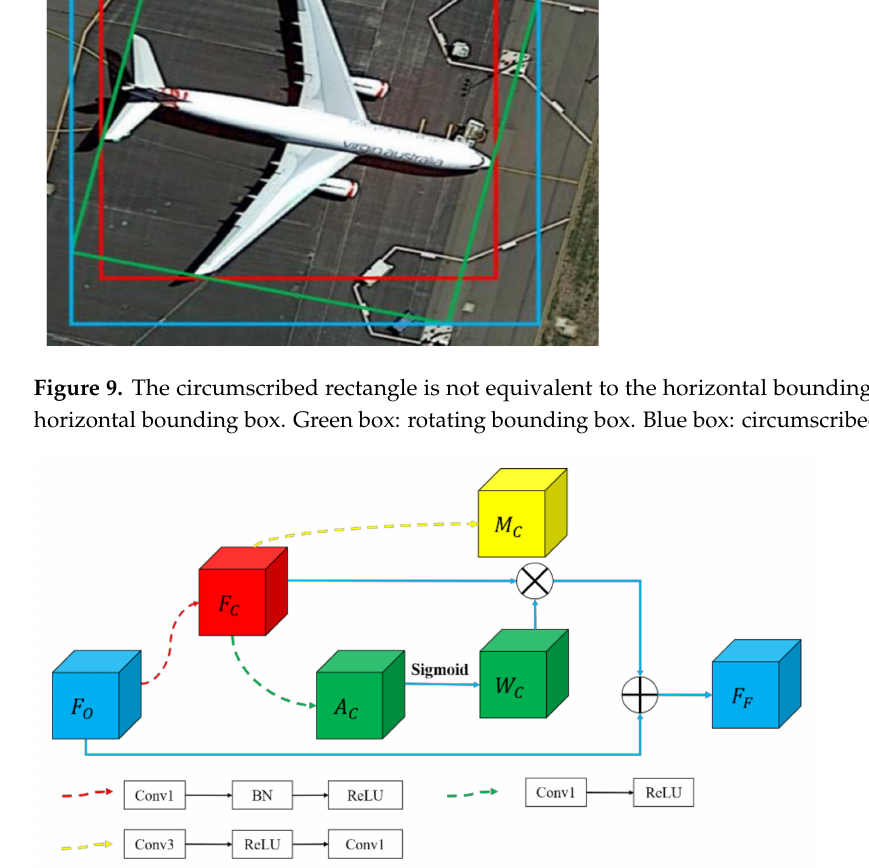
Figure 10. Center vertex attention